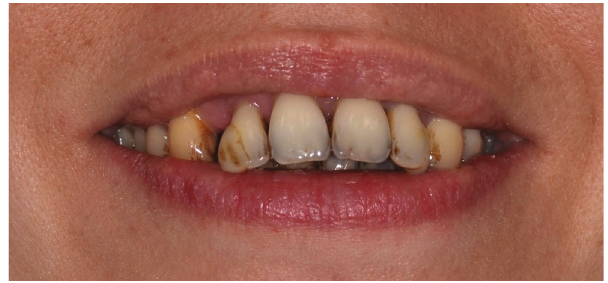
Figure 1: Clinical case: frontal view.